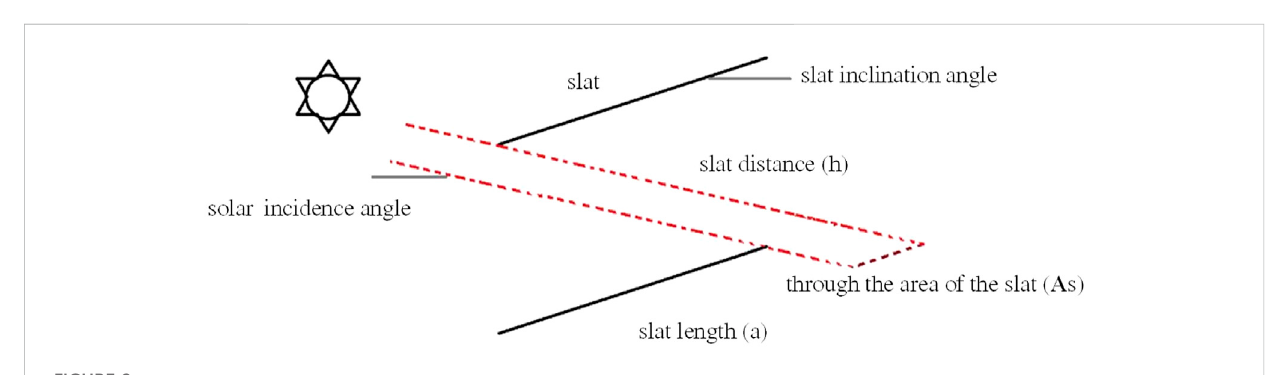
FIGURE 2 Schematic diagram of direct sunlight through PCM